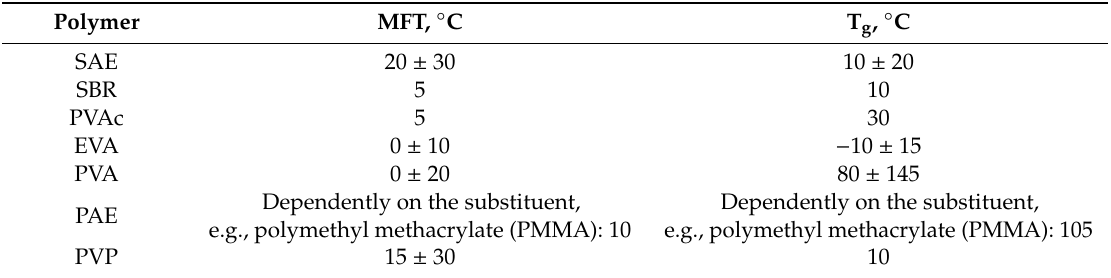
Table 2. Examples of values of minimum film-forming temperature (MFT) and glass transition temperature (T g ) of the polymers